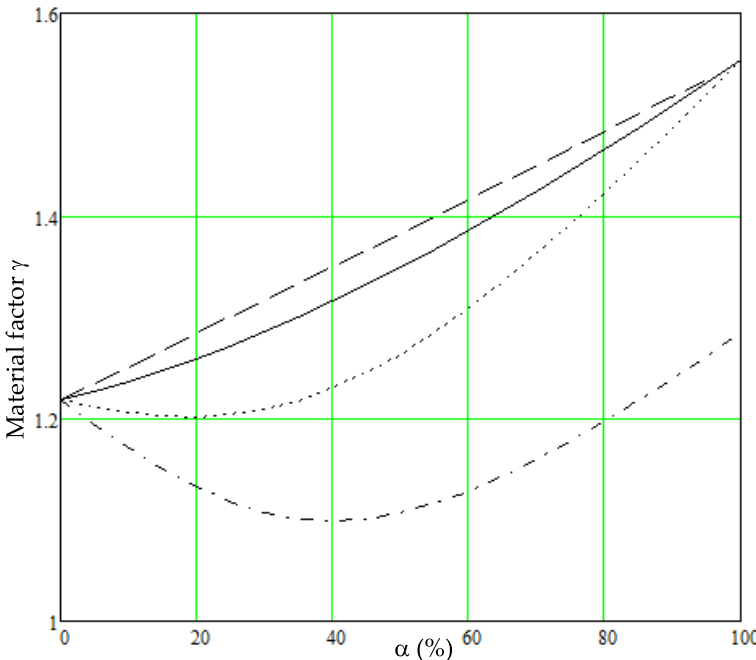
Figure 2. Material safety factors of timber; dash-dotted line, current calculation, the variable load is in the 5-year mode; dotted line, the ILC with the variable load in the 50-year mode; solid line, the DLC; dashed line, the variable load is assumed constant.